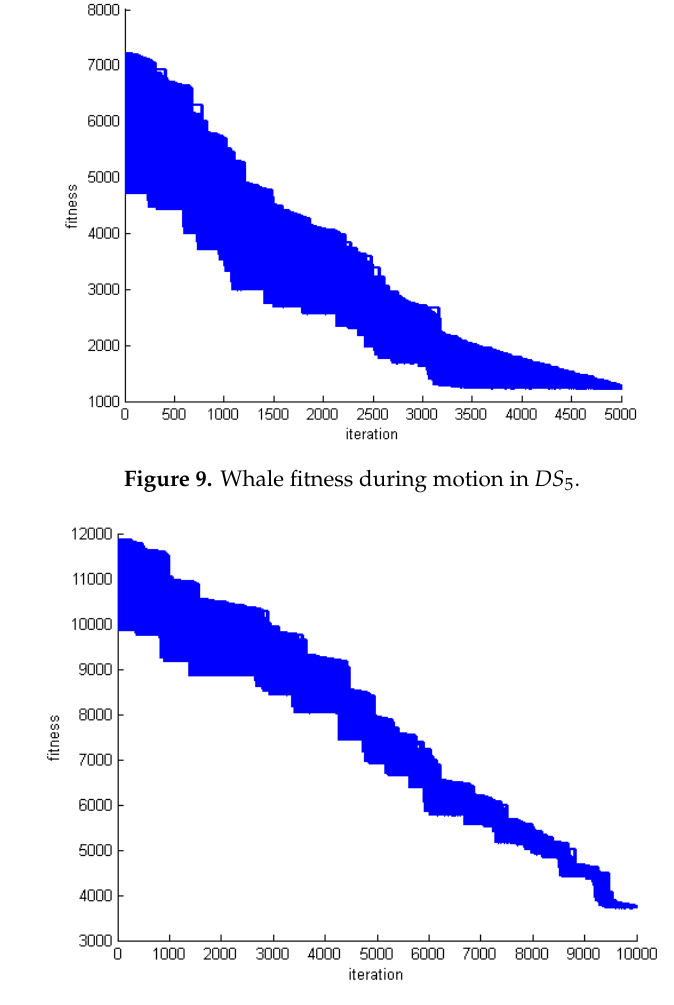
Figure 10. Whale fitness during motion in DS 8 .